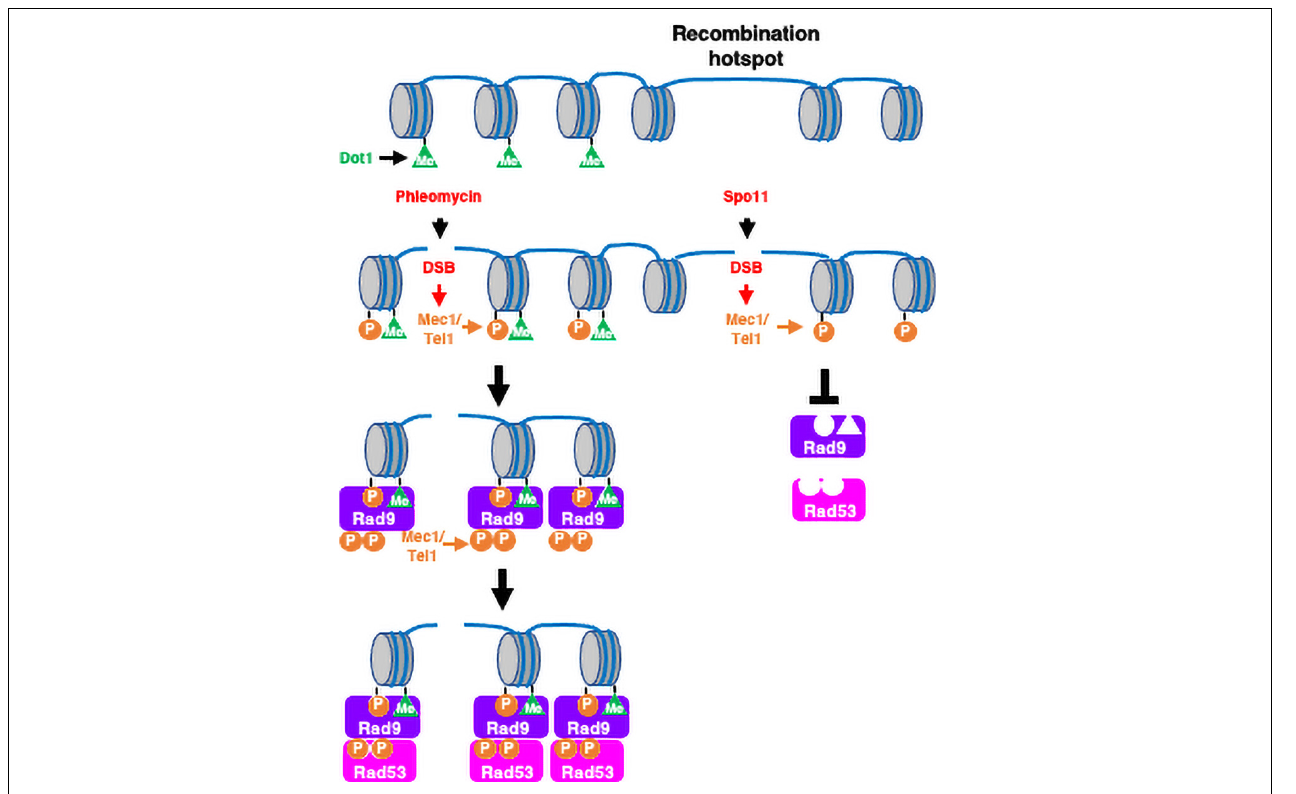
FIGURE 6 | Rad9 is incompetent to meiotic DSBs. Exogenous DSBs often occur in nucleosome-rich gene body where Dot1-mediated histone H3K79 methylation marks are enriched (left pathway). The DSBs activates Mec1/Tel1, which in turn phosphorylates histone H2AS129. The two epigenetics marks, H3K79 methylation and H129S phosphorylation, provides multiple binding sites to Rad9. Rad9 is phosphorylated by Mec1/Tel1 and activates Rad53 kinase. At recombination hotspots is located in nucleosome-free region, which shows less H3K79 methylation compared to gene bodies right pathway. This chromatin features make the region insensitive to Rad9